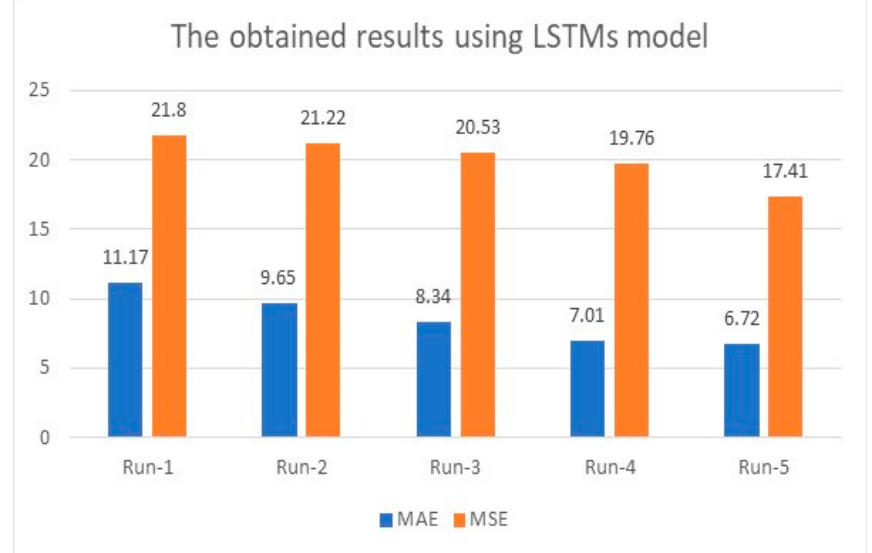
Figure 8. MAE and MSE evaluation using LSTMs tool.